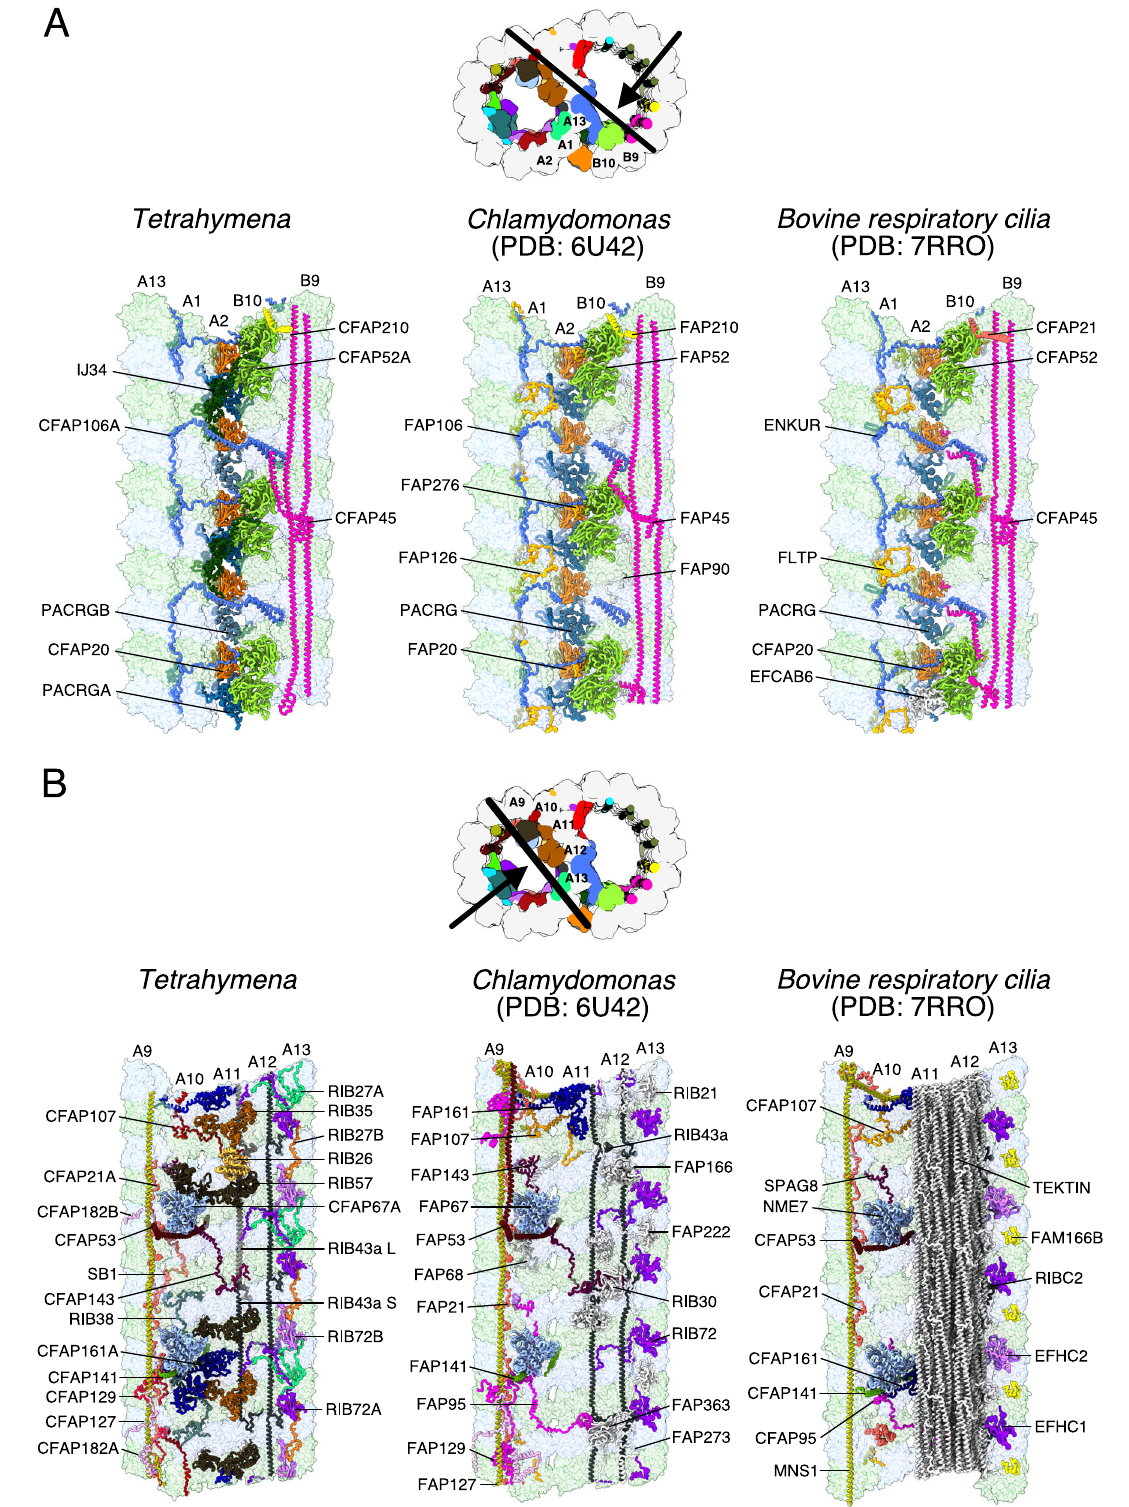
Fig. 2 | Comparison of the DMT structure from Tetrahymena , Chlamydomonas and bovine respiratory cilia. A The inner junction, note that the architecture is well conserved. B The PF-ribbon region, note many species-speci fi c